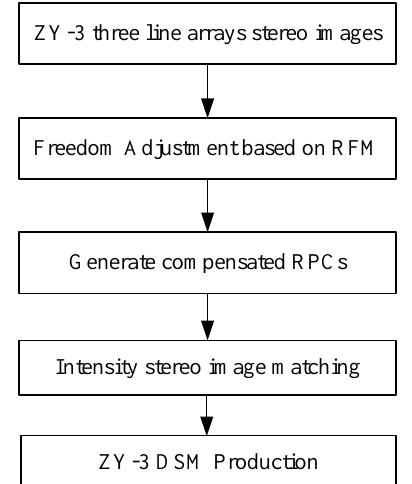
Figure 2. The workflow of ZY-3 DSM generation According to the horizontal coordinate of ICESat/GLAS point, h can be interpolated from the the corresponding elevation DSM DSM grids. The elevation difference can be calculated from